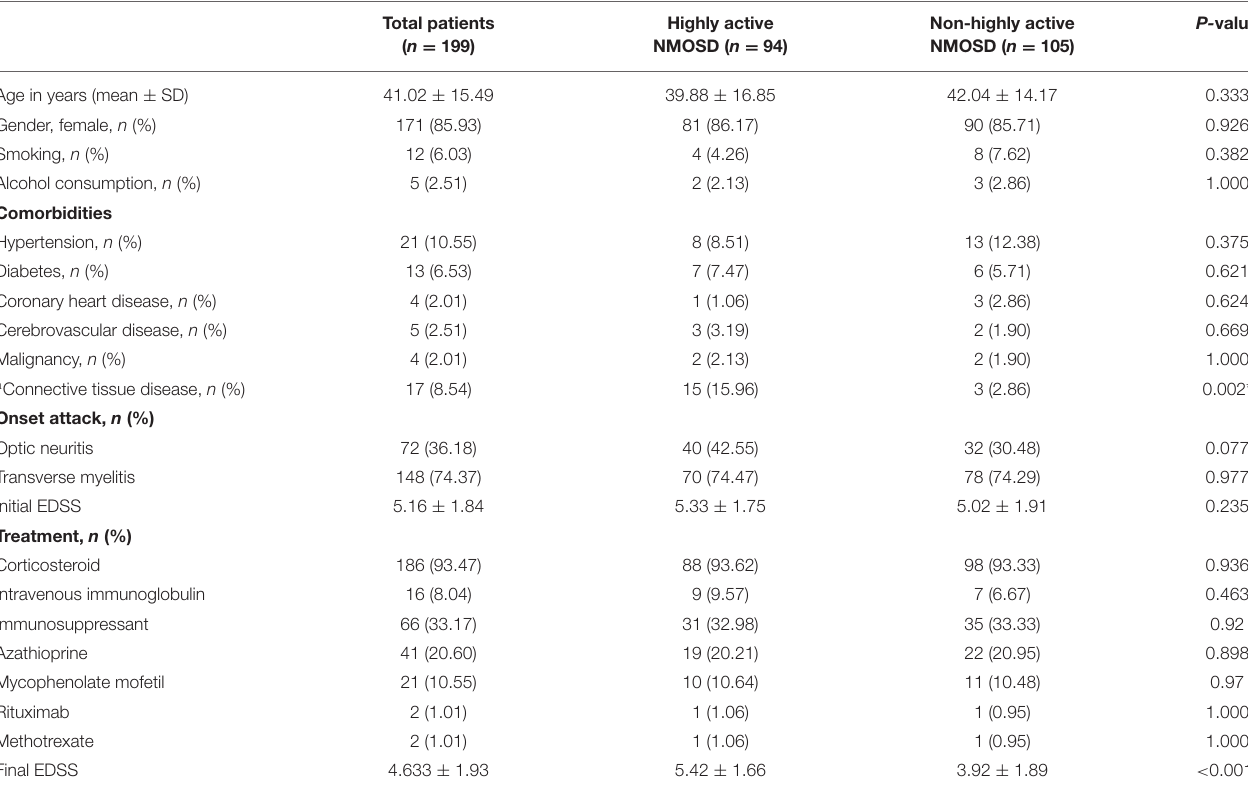
TABLE 1 | Comparison of clinical data between patients with highly active NMOSD and non-highly active NMOSD patients.